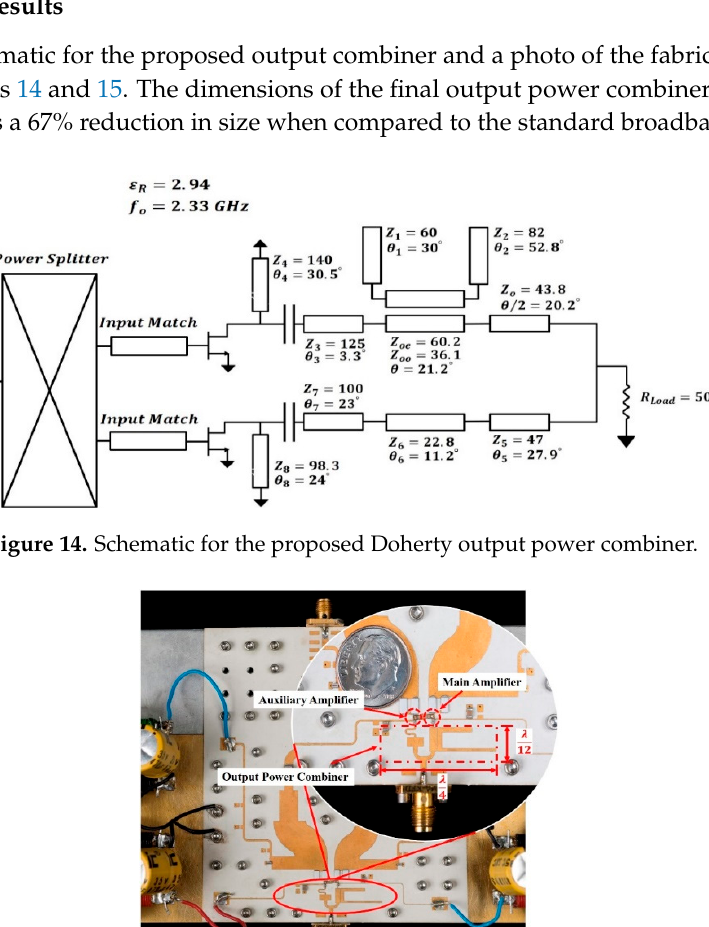
Figure 13. Final schematic used to optimize the complete output power combiner.